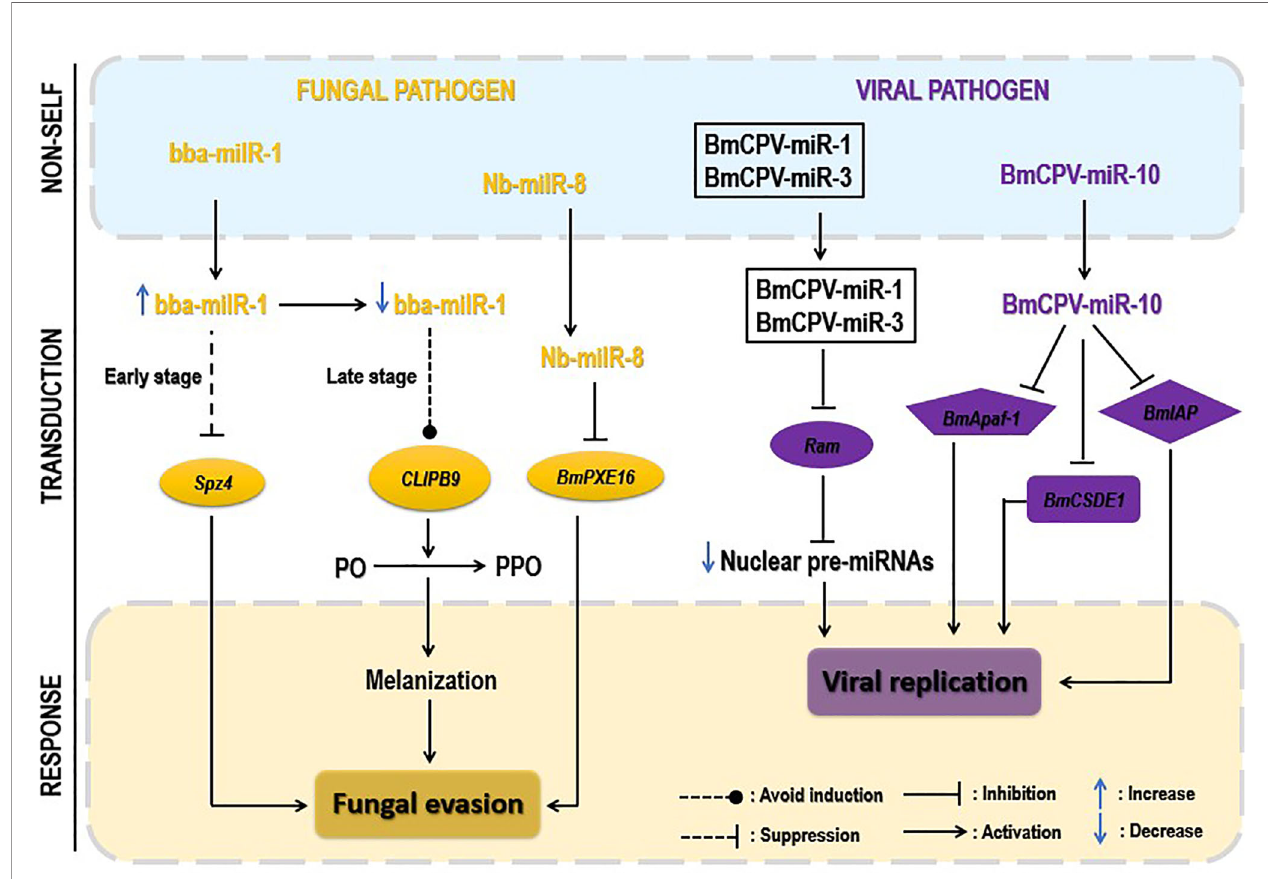
FIGURE 6 | Pathogen-encoded miRNAs regulating insect immunity. Pathogen-derived miRNAs often translocate via extracellular vesicles (EVs) to regulate insect host immunity. Upon fungal invasion, translocated fungal miRNAs downregulate the insect Toll signaling pathway by repressing the expression of critical genes, such as Spz4 , or inhibiting the peroxisome pathway, repressing the expression of the PXE16 gene. At the late stage of infection, fungi act by decreasing the expression of their miRNAs to escape the melanization process (yellow). Upon viral attacks, translocated virus-derived miRNAs act individually or synergistically to negatively regulate the expression of insect key genes (Ran, Apaf-1, etc.) by targeting their 3 ′ UTR regions. The latter downregulation reduces host miRNAs ’ production, leading to viral replication and proliferation (purple). However, the fi gure does not show the bacterial-derived miRNAs due to missing data on their role in insect – bacterium